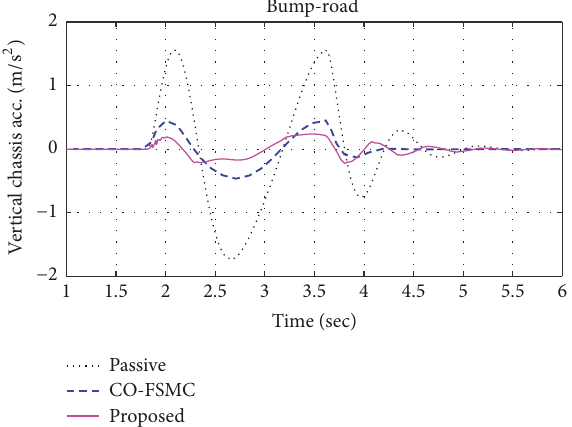
Figure 10: The bump-typed track profile: vertical chassis accelera- tion corresponding to each method.